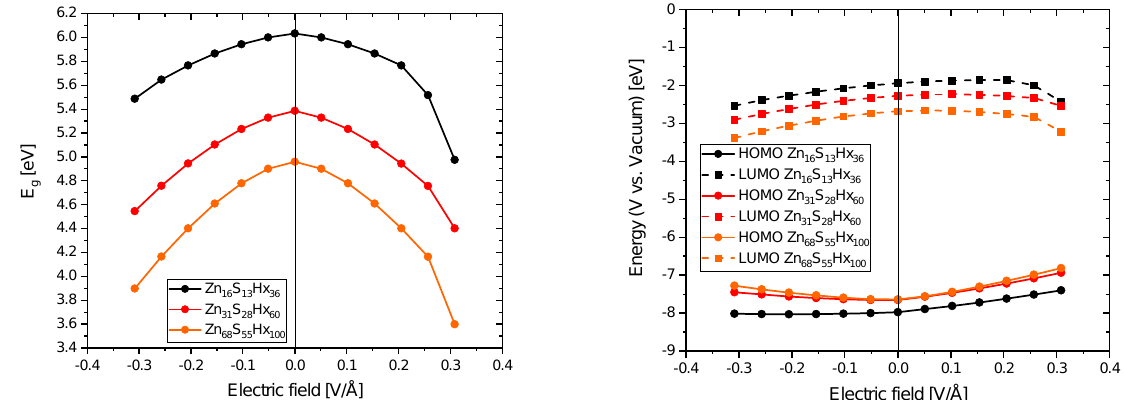
Figure 7. E g of different sized QDs ( left ) and the energetic position of the highest occupied molecular orbital (HOMO) and lowest occupied molecular orbital (LOMO) ( right ) as a function of the applied electrical